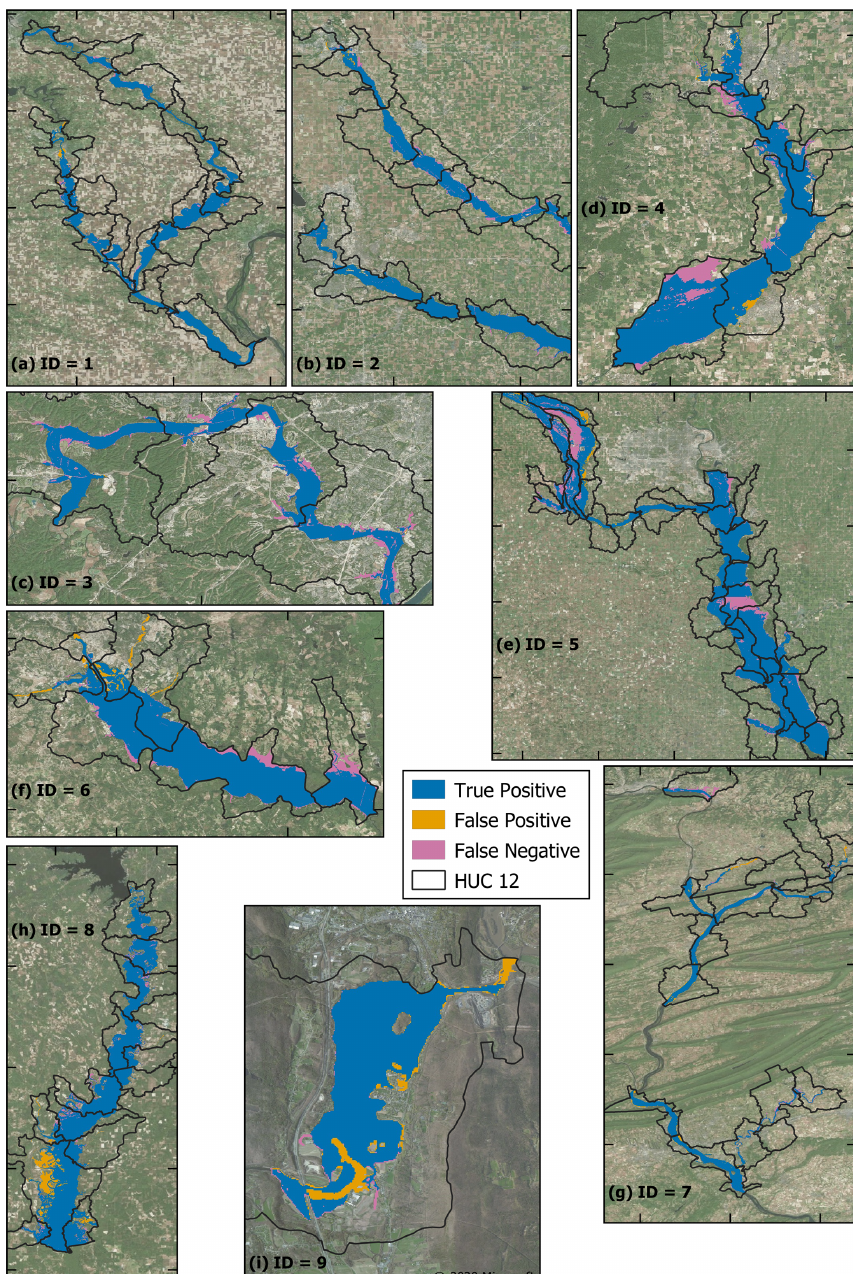
Figure 4. Maps illustrating the similarity between modelled flood events and HWM-derived extents in relevant hydrologic unit code (HUC) 12 zones. Interior tick marks are spaced 0.25 ◦ ( ∼ 27km) apart. Imagery sourced from © 2020